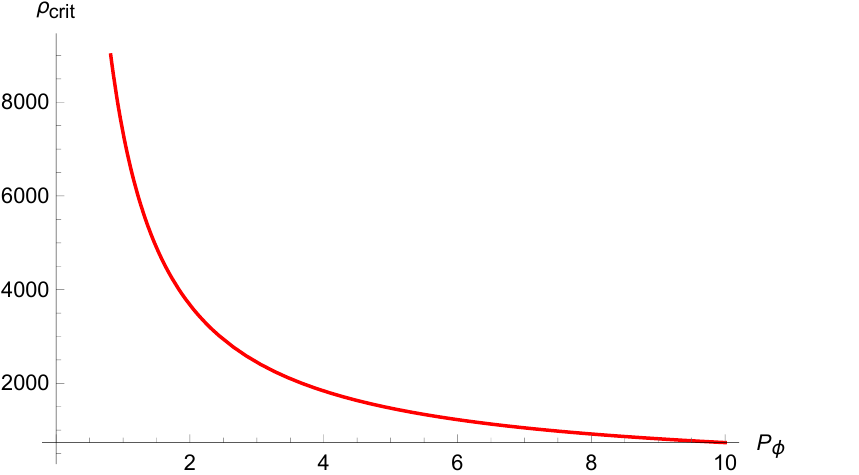
Figure 4. Dependence of the critical energy density on the momentum of the scalar field. For P φ → 0 the Bounce approaches the